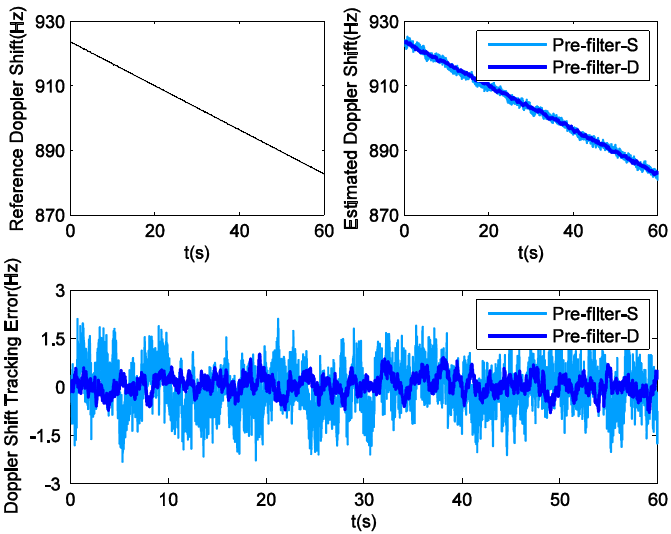
Figure 4. Doppler shift tracking error for PRN25 in field test.